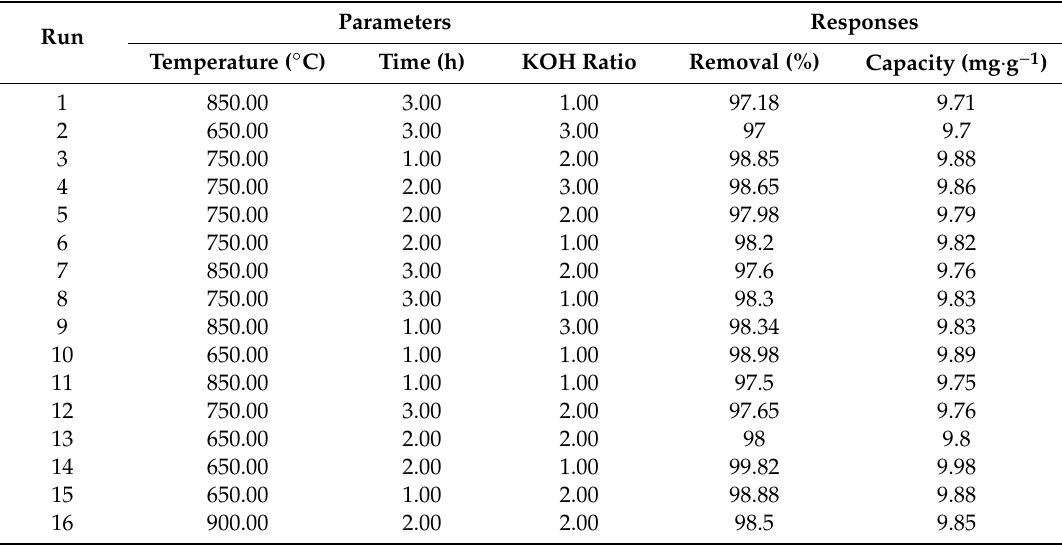
Table 2. Experimental design for preparation bio-powder-activated carbon (bio-PAC) and results. Parameters Responses Run Temperature ( ◦